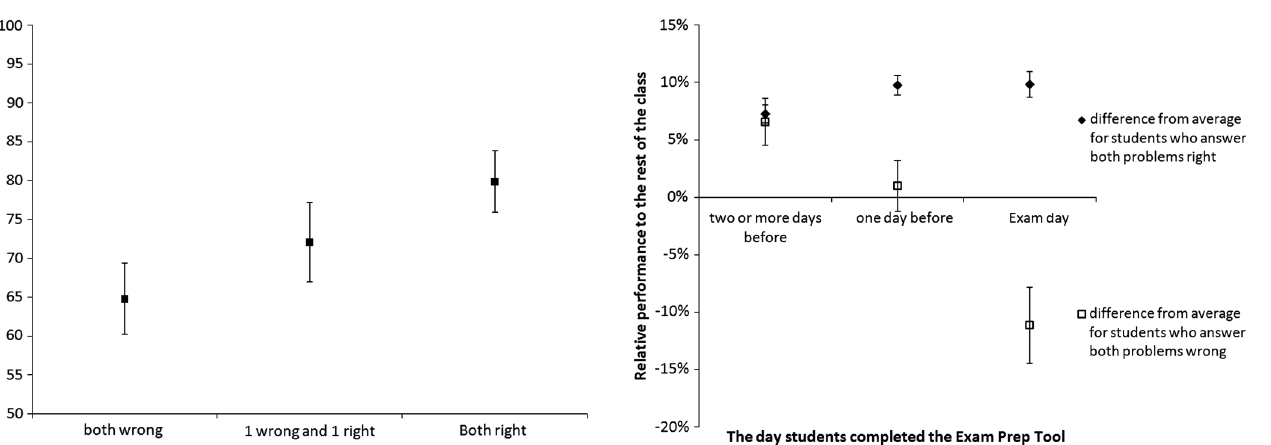
FIG. 5. Student relative performance on exam problems for topics the exam-prep tool predicted they would perform well on (diamonds), compared with topics the tool predicted they would not perform well on (squares). Early on, the predictive power is very weak, perhaps because students had time to work on the material they did not know. However, on the exam day the predictive power was quite good, showing a 20% difference in student